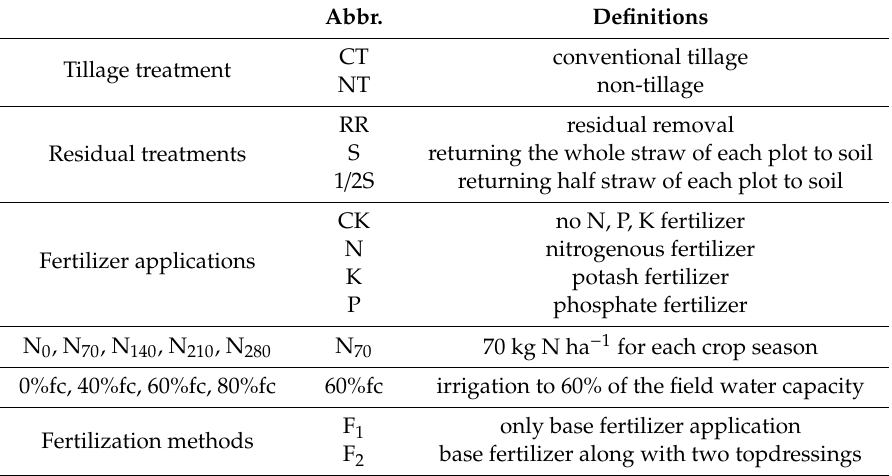
Table 3. Abbreviations of agronomic treatments in Table 2.